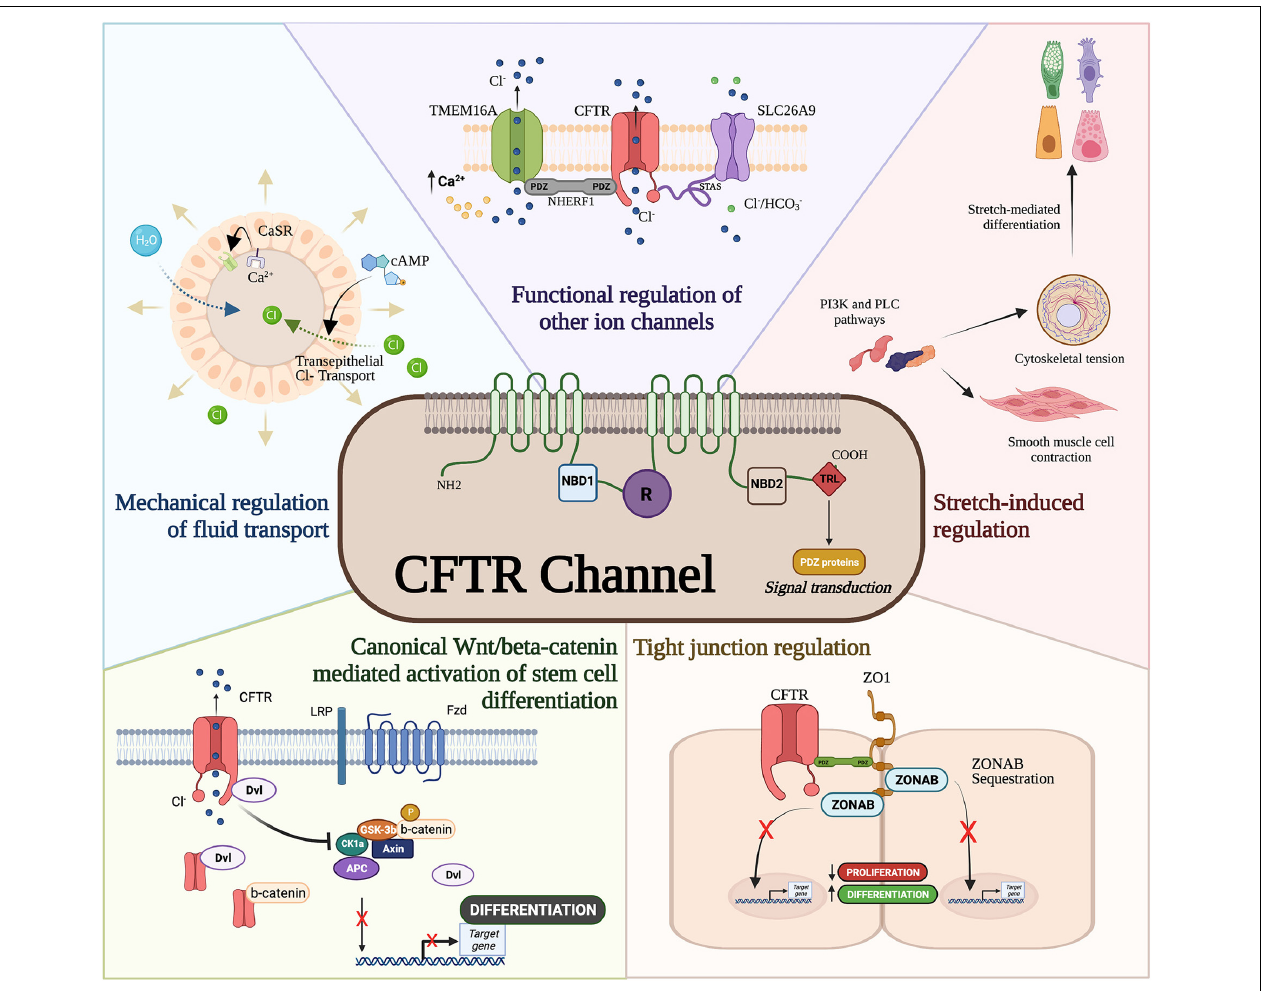
FIGURE 1 | Cystic fibrosis transmembrane conductance regulator (CFTR) developmental interactome. The CFTR channel has been associated with developmental processes and regulatory pathways. CFTR mediates mechanical forces for airway development, functionally regulates other ion channels, drives differentiation through ZO-1, interferes with canonical Wnt/ β -catenin activation of stem cell differentiation, and modulates smooth muscle cell contraction and cytoskeletal